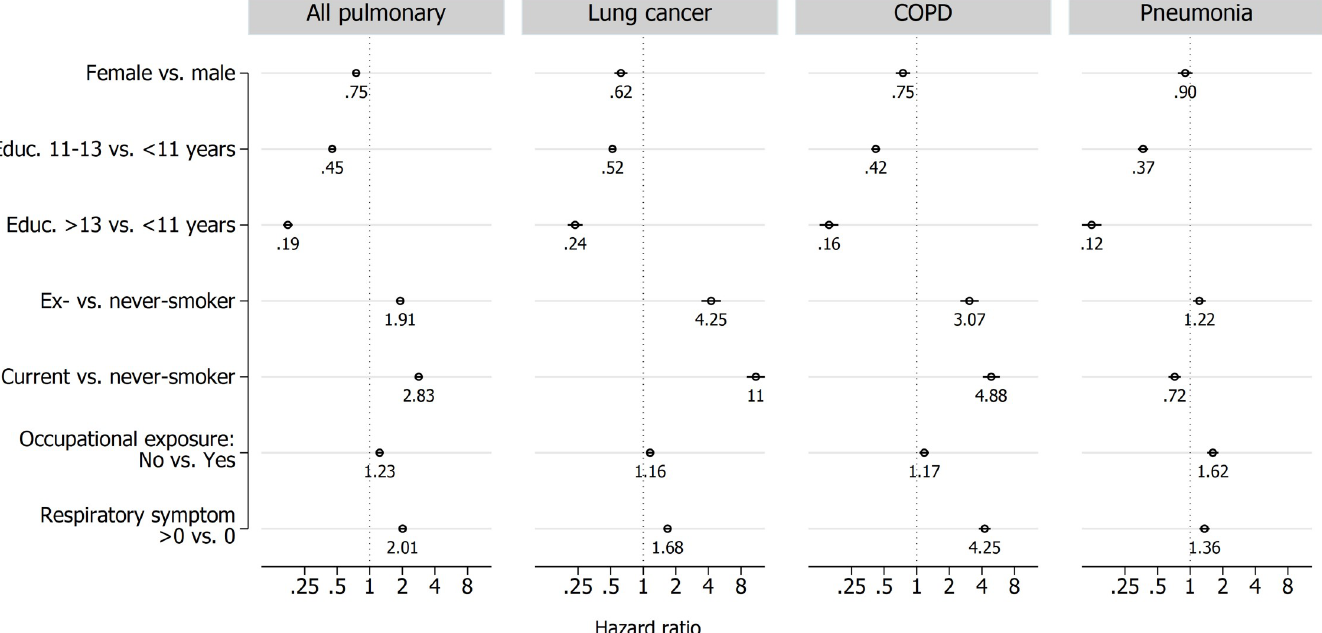
Fig 1. Associations with cause-specific mortality. Multivariable hazard ratios with 95% confidence intervals for any respiratory symptom (0 = no, 1 = yes), sex, education, smoking and occupational exposure to air pollution according to all pulmonary deaths, lung cancer, COPD or pneumonia. All subjects in pooled sample with available covariates (n =